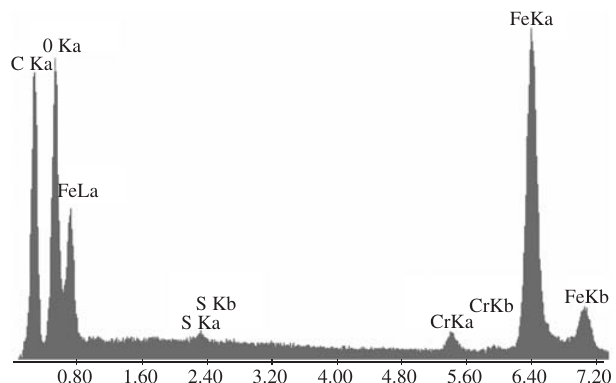
Figura 13 . Chemical composition obtained by EDX analysis of the structures indicats in Figure 12.